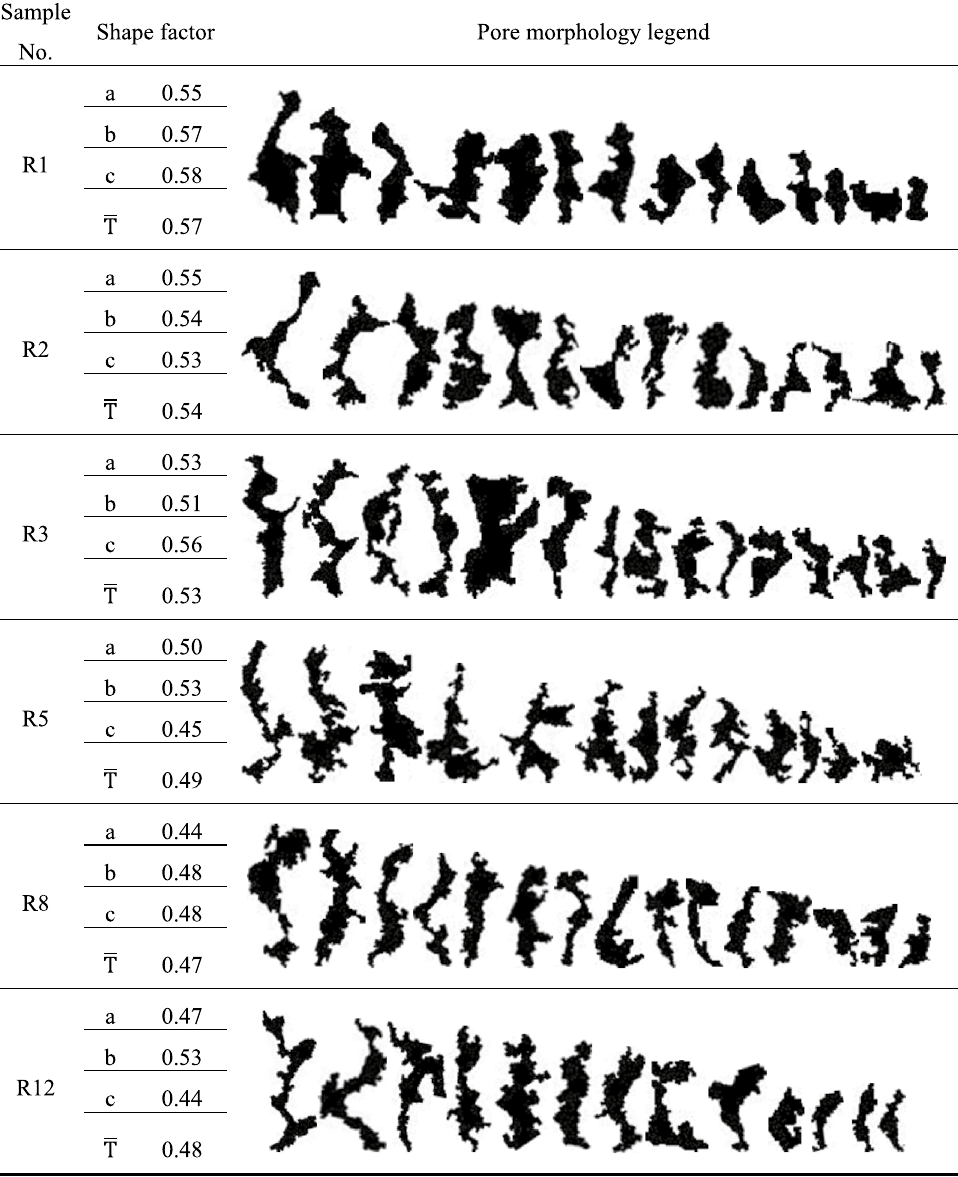
Table 4. Pore shape factor of red-bed soft rock in different water–rock interaction